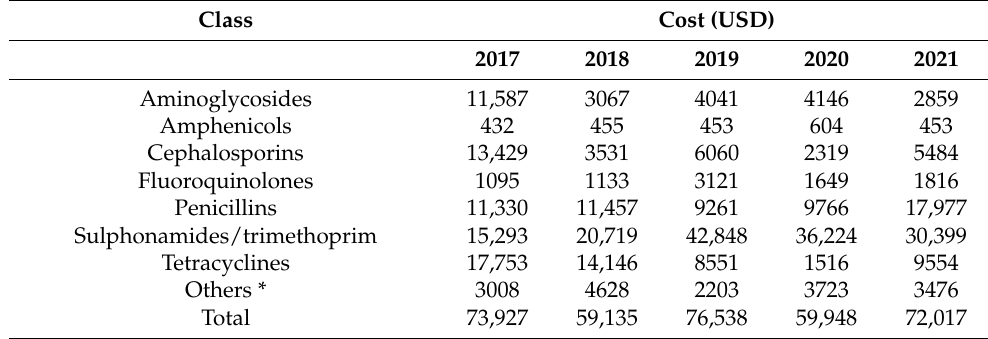
Table 7. Annual expenditure on antimicrobials for livestock in Bhutan. Class Cost